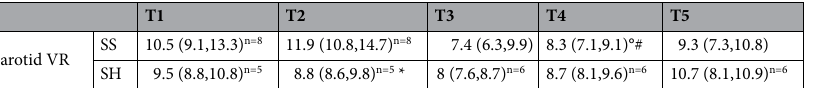
Table 3. Medians (25–75th percentiles) values of carotid vascular resistance computed at each time point for the two groups (septic pigs SS n = 9, sham pigs SH n = 7, if not stated otherwise in the table). Carotid VR = carotid vascular resistance [mmHg/mL/min/Kg], Comparison between Sepsis and Sham: * p -value < 0.05 (Wilcoxon rank sum test). Wilcoxon signed test: ° p < 0.05 with respect to T1, # p < 0.05 with respect to T2 (Friedman test p -value < 0.05).